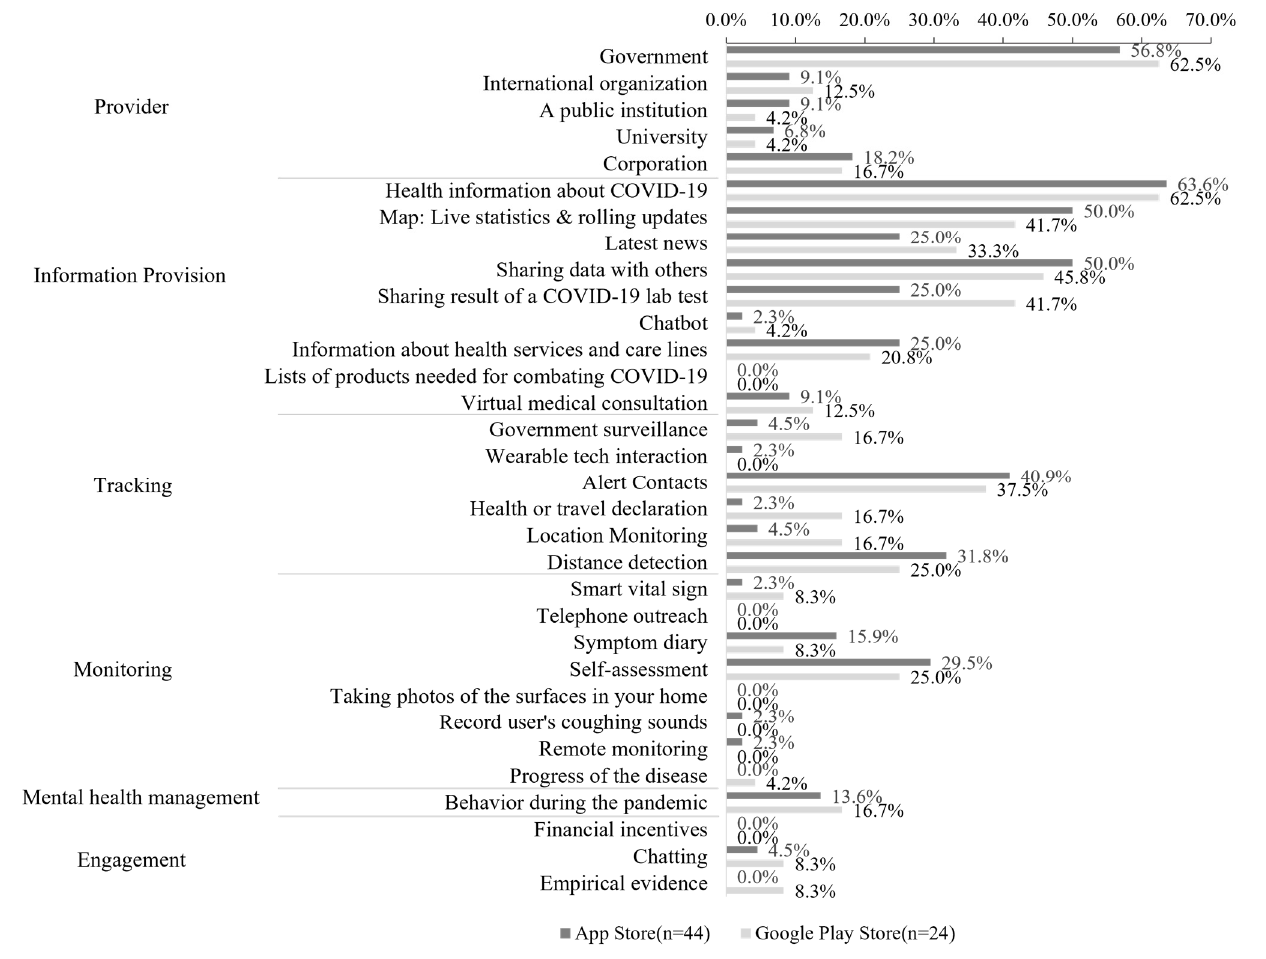
Figure 3. Result of the COVID-19 app content analysis.